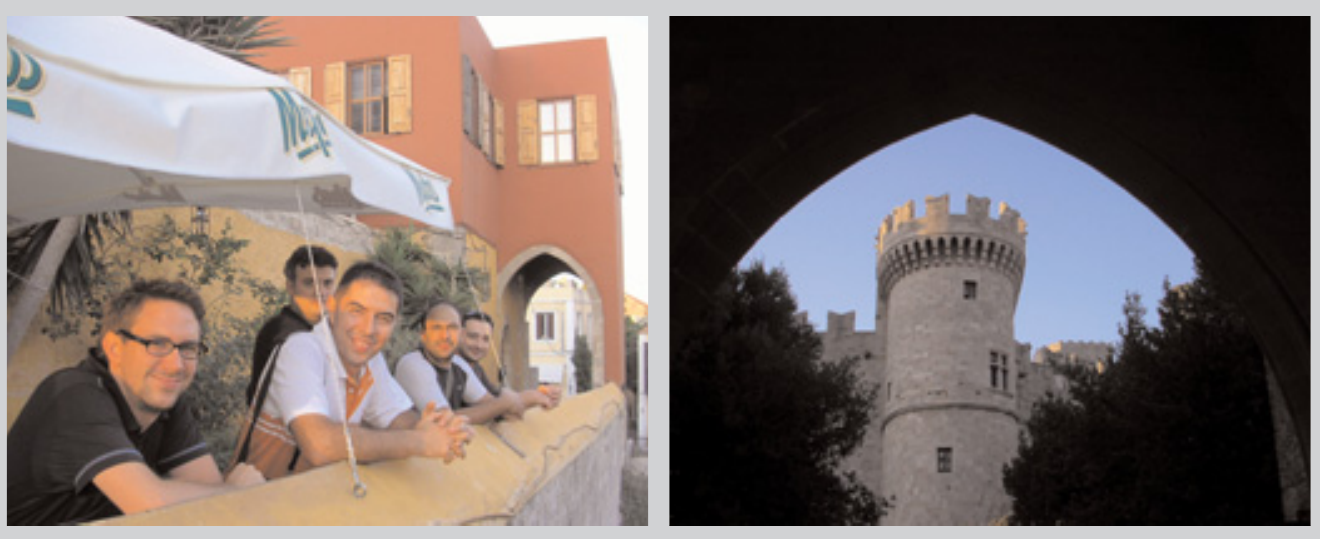
Figure 3 (left): Vlasis Mavrantzas, local organizer, surrounded by participants. (photo taken by Brian Edwards) Figure 4: Part of Rhodes firtification of the 14th–15th century built by the Knights of Saint John. (photo taken by Brian